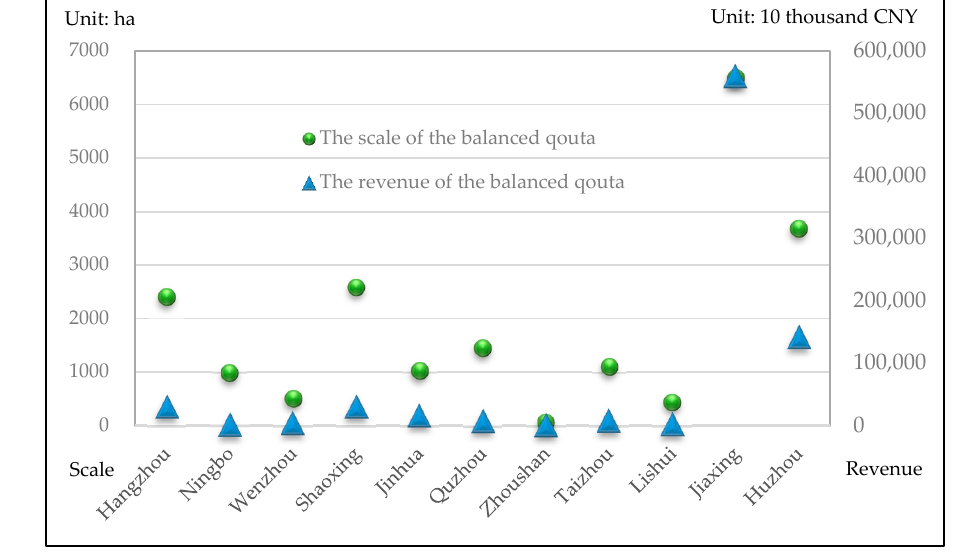
Table 2. Comparison of the scale and revenue of the balanced quota in different projects. Balanced Quota